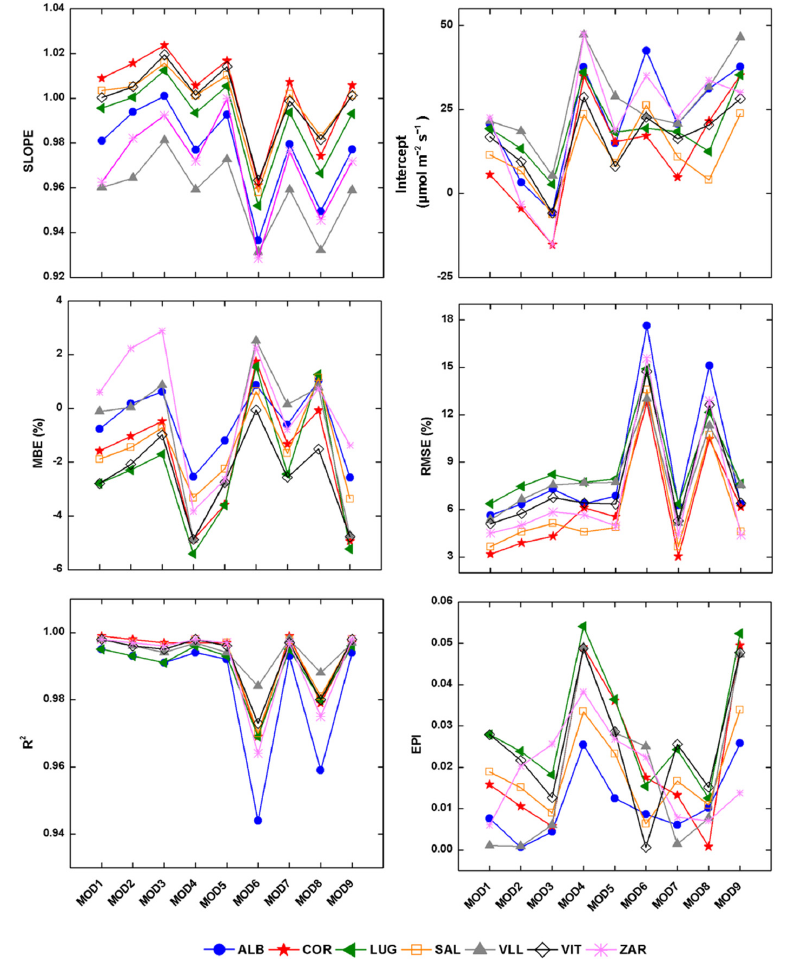
Figure 3. Statistical results of the nine MR models for each station.